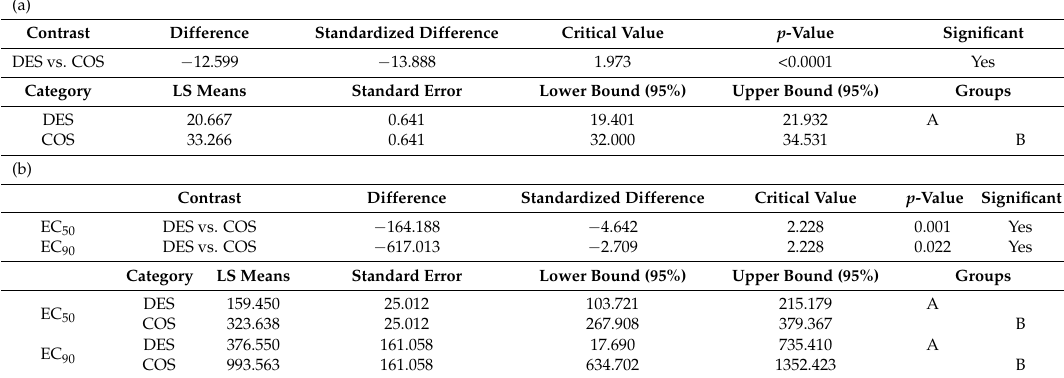
Table 2. Analysis of the differences in radial growth values ( a ) and EC 50 and EC 90 values ( b ) between the two dispersion media with a confidence interval of 95% by Tukey’s HSD